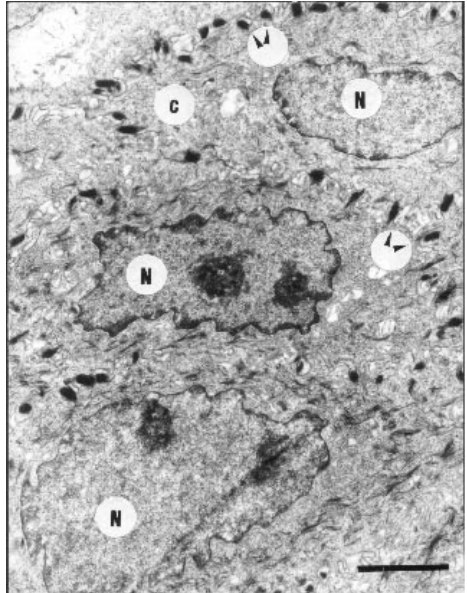
Figure 3 - Transmission electron micrograph of neovagina squa- mous epithelium with abundant cytoplasm, clearly visible nu- cleoli and numerous desmo- somes (arrow). There are some areas suggesting interdigitation (*) of cells with occasional re- sidual microvilli (M). This evi- dence suggests a squamous metaplasia of amniotic tissue. Lead citrate and uranyl acetate staining (bar = 1